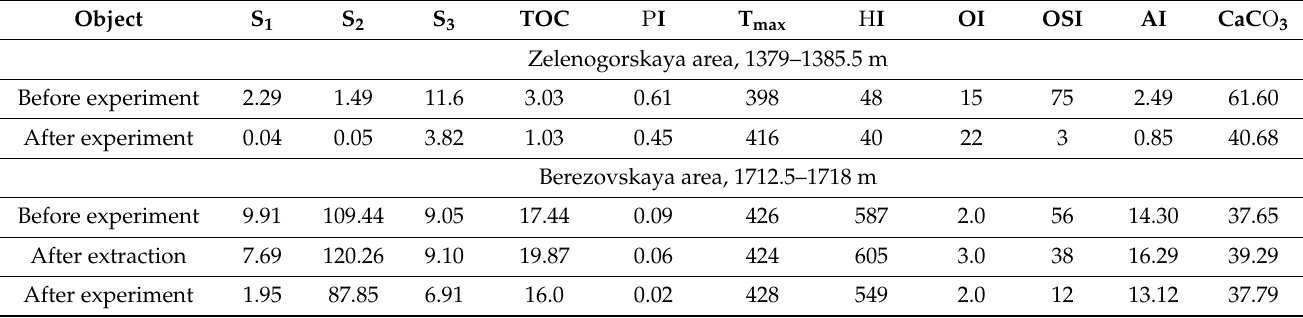
Table 1. Characterization of rock samples according to the Rock–Eval pyrolysis